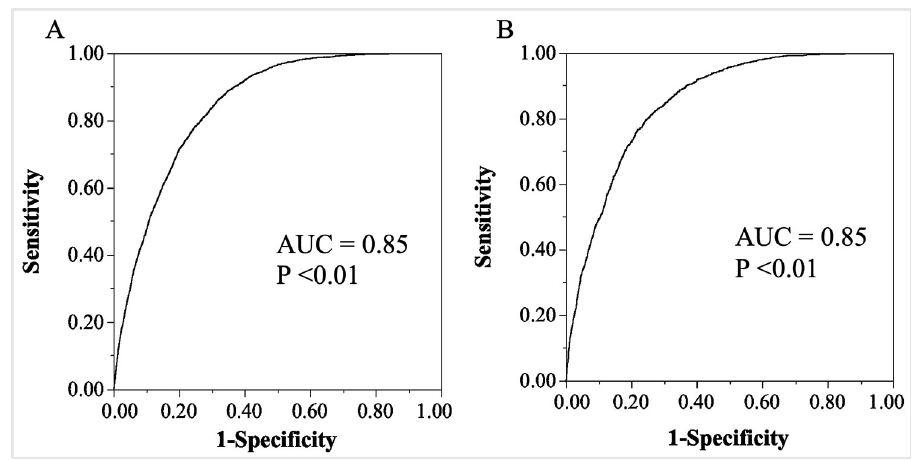
Fig 4. Five-year metabolic syndrome risk score prediction ability for the equation model in derivation and validation cohorts. The predictive ability of the equation model was assessed using ROC curve analysis to determine the AUC for the derivation and validation cohorts. A. Derivation cohort B. Validation cohort. AUC, area under the curve; ROC, receiver operating characteristic.